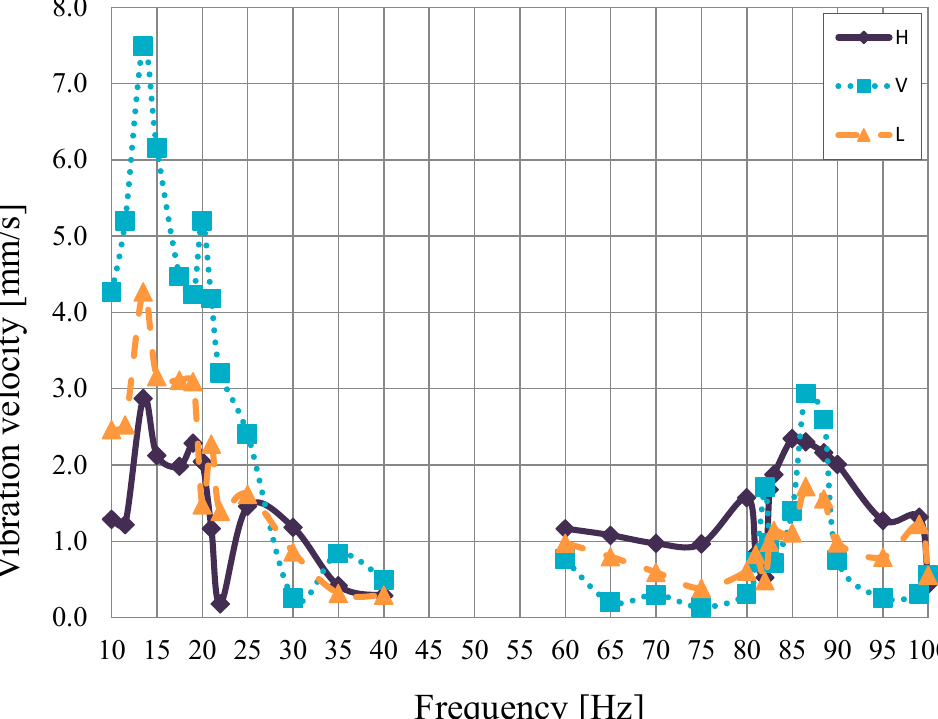
Figure 25. Measured broad-band vibration velocity for Case B in the horizontal (H), vertical (V) and longitudinal (L) directions versus the frequency of voltage subharmonics and interharmonics occurring as a single power quality disturbance.